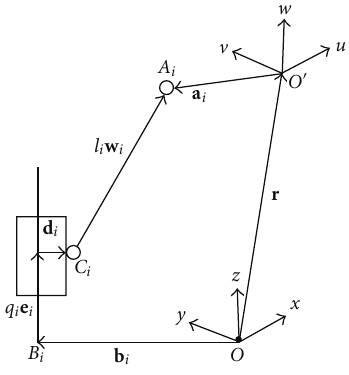
Figure 2: Vector diagram of a PSS kinematic.